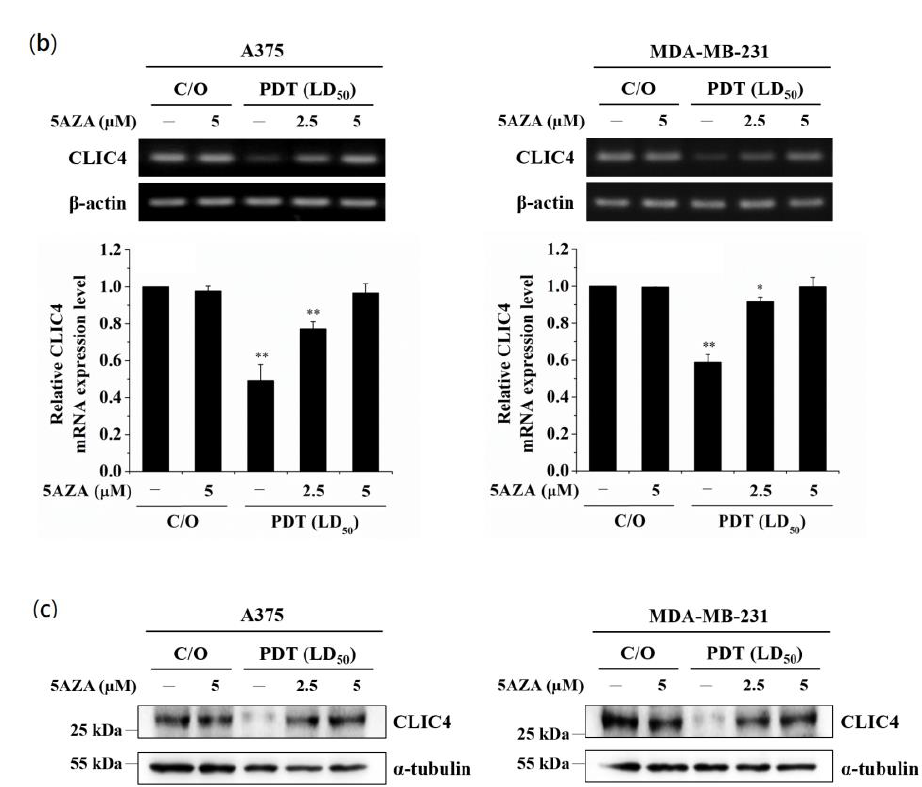
Figure 1. Inhibition of DNA methylation relieves the suppression of CLIC4 expression induced by PDT-mediated oxidative stress. Cells were pre-incubated with 5AZA for 2 h prior to light irradiation. For ALA-PDT, cells were pre-incubated with 1 mM ALA for 3 h and then exposed to specific wavelength (635 ± 5 nm) of light, 2 J/cm 2 and 4 J/cm 2 for A375 (left panel) and MDA-MB-231 (right panel) cells, respectively. To verify the mRNA expression level of CLIC4, total RNA samples were isolated ( a ) from PDT-treated cells at the time indicated (4, 8, 16 and 24 h after ALA-PDT) with or without pre-incubation of 5 µ M 5AZA, and ( b ) from PDT-treated cells at 24 h as indicated with or without pre-incubation of 2.5 and 5 µ M 5AZA. The relative mRNA expression level of each gene was measured by RT-PCR and normalized to β -actin; ( c ) The protein expression level of CLIC4 was analyzed by Western blotting, and α -tubulin was used as an internal control. The control group was cells only treated with ALA w/o light irradiation. For electrophoretic gels, the same volume of each PCR product was loaded, and band blots for each gene were cropped from different gels. For immunoblots, equal volume of each sample with the same concentration was loaded into each well, and the blots were cropped from different sections of the same gel. Data represent from three independent experiments. Each bar shown is the mean fold change relative to control ± SD. Results are considered to be statistically significant at * p < 0.05 and ** p < 0.01.